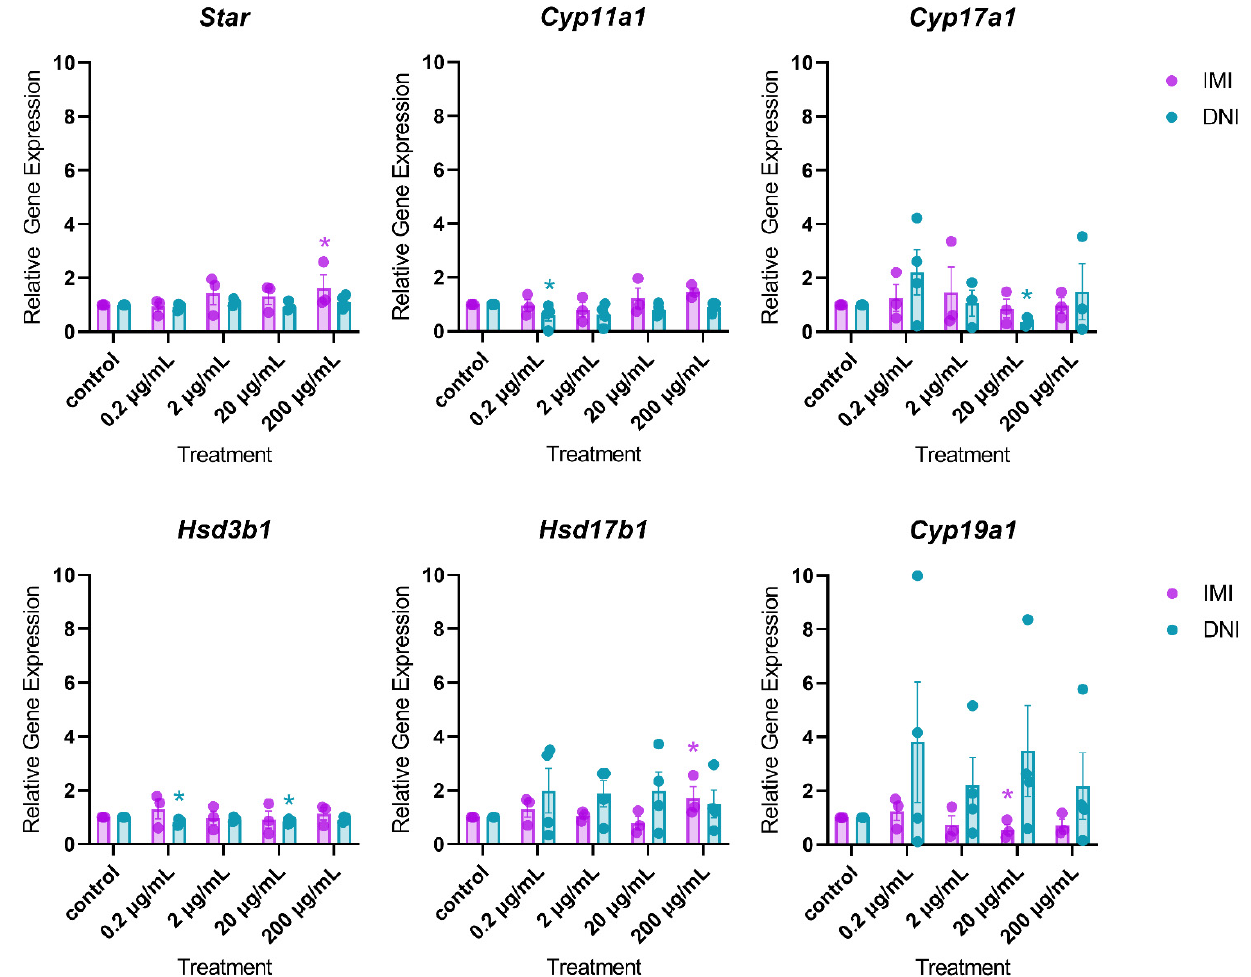
Figure 7. Effects of IMI and DNI on the gene expression of steroidogenic regulators in antral follicles treated with a vehicle (DMSO or water), IMI, or DNI (0.2–200 µg/mL) for 72 h. After the culture period, RNA was extracted from snap-frozen follicles, reverse-transcribed to cDNA, and subjected to qPCR. The graphs indicate means ± SEMs from 3–5 separate cultures (8–12 follicles per treatment per culture). * p < 0.05.